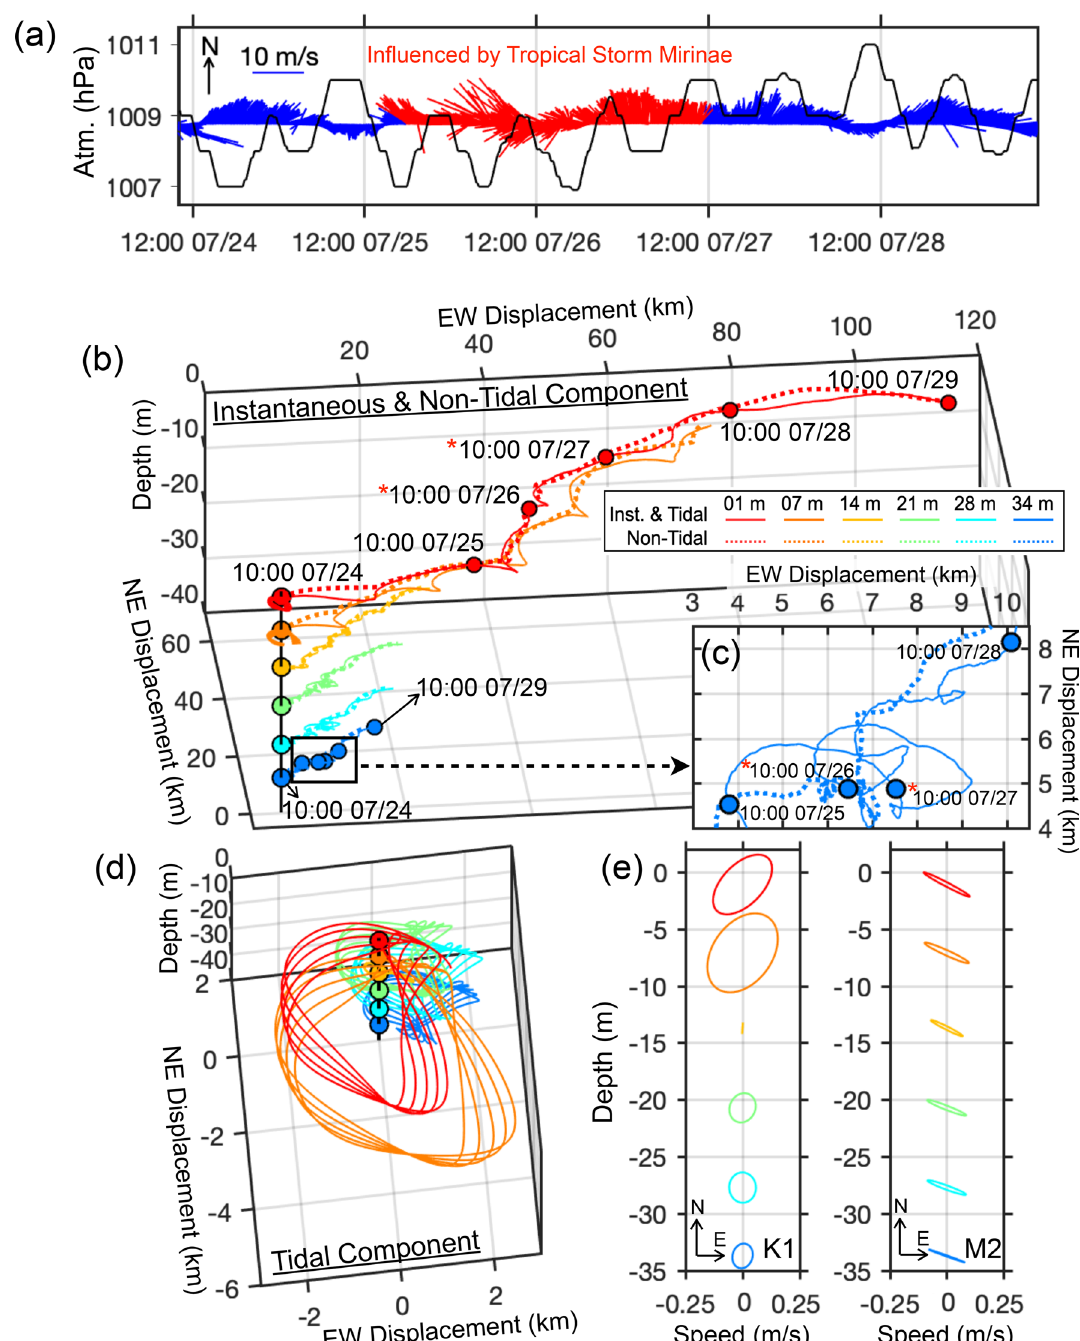
Figure 2. The meteorological background and current field measured at ZHJ2. ( a ) The stick diagram of the wind field and atmospheric pressure measured aboard the research vessels. The stick diagrams are plotted according to the oceanographic convention. The north is the upward direction. Both the wind and pressure fields were plotted at 20-min interval. The duration influenced by Tropical Storm Mirinae is marked by red stick. ( b ) The PV of the flow field (color-coded for different depths). Warm colors represent layers near the surface. Cold colors represent layers near the bottom. The instantaneous flow and non-tidal components are plotted as solid lines and dash lines, respectively. The times influenced by Tropical Storm Mirinae are marked with the red stars. ( c ) The enlarged portion of the PV at 34 m marked with the black square in ( b ). ( d ) and ( e ) are the 3-D view of tidal current component and tidal current ellipses at different depths with the same color